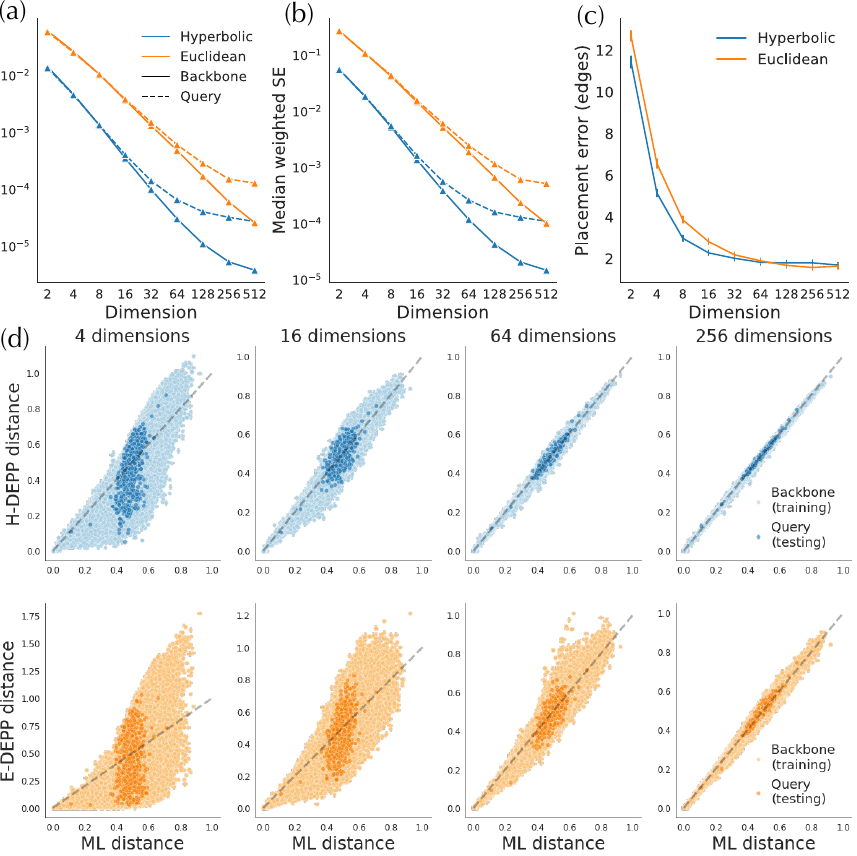
Figure 5. Hyperbolic and Euclidean embedding of WoL 16S data. ( a ) Median squared error of embedding distances. ( b ) Median squared error of embedding distances weighted by tree distances. ( c ) Placement errors ( d ) True vs. estimated tree